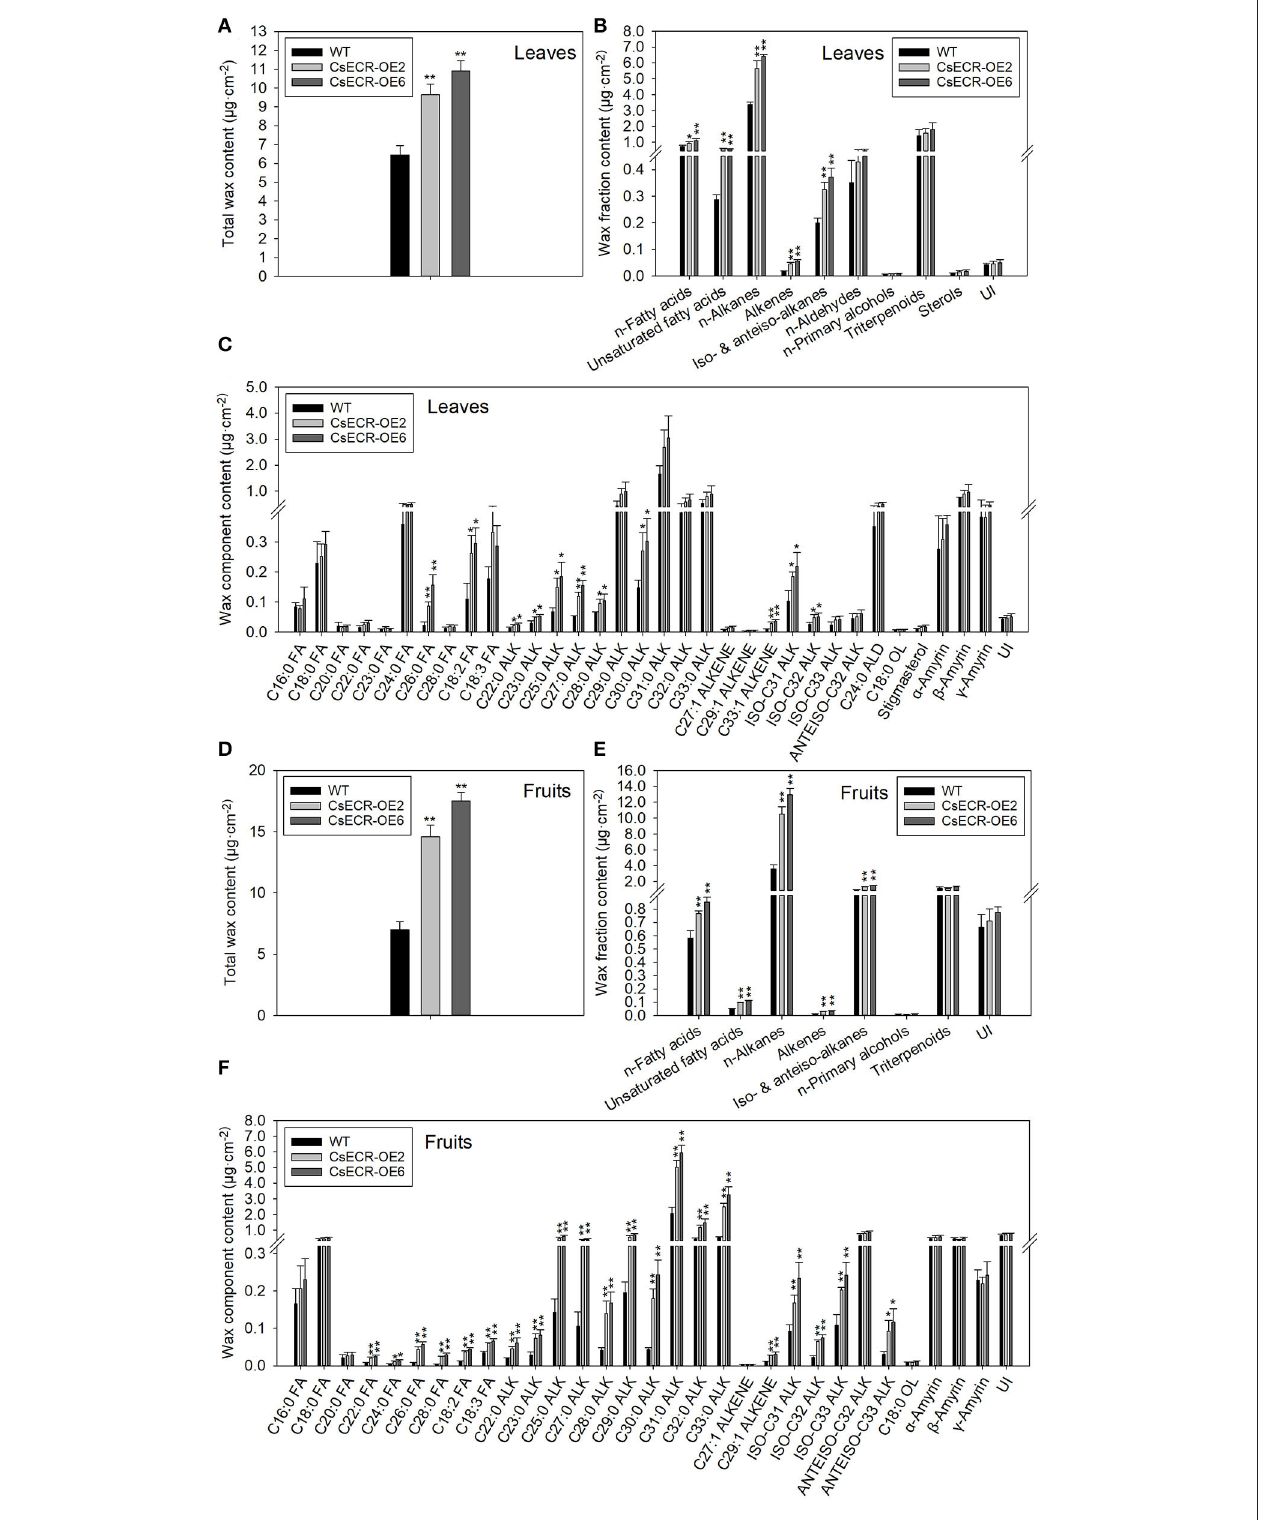
FIGURE 5 | The contents of total waxes, wax fractions, and wax constituents of (A–C) leaves and (D–F) fruits in the WT and two transgenic tomato lines (CsECR-OE2 and CsECR-OE6). FA, fatty acid; ALK, alkane; ALD, aldehyde; OL, alcohol; UI, unidentified components. Vertical bars represent standard deviations of the means ( n = 3). Significant differences between the WT and transgenic tomato lines at the P < 0.05 and P < 0.01 levels were indicated by single and double asterisks, respectively, according to Student’s t -test.